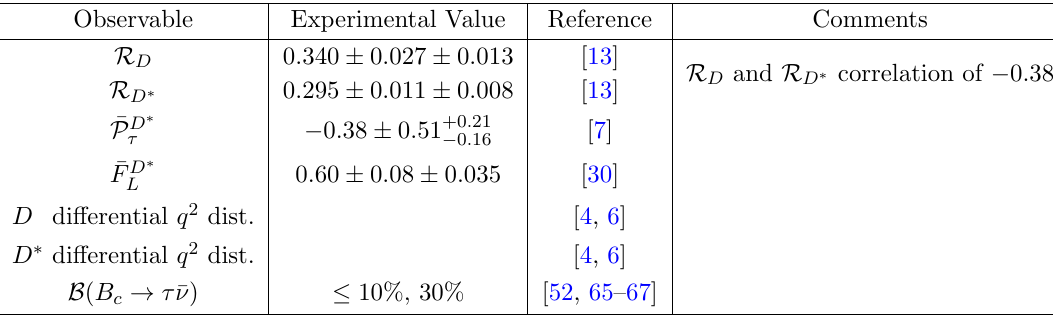
Table 2 . Experimental inputs used in our